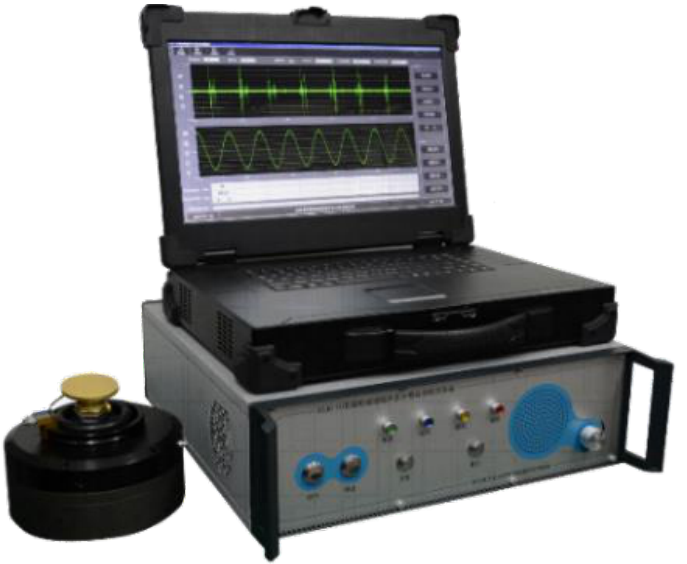
Figure 2. DZJC-III PIND loose particle automatic detection system.